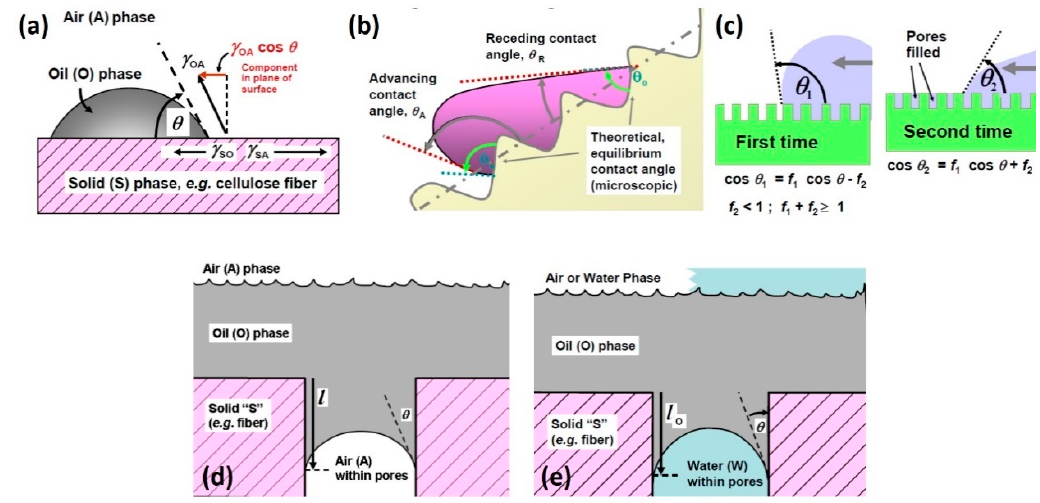
Figure 3. Processes taking place at the liquid–solid interface between oil and sorbent materials. ( a ) Wettability of oil on the surface of a sorbent, ( b ) advancing and receding angles on a rough surface, ( c ) Cassie and Baxter’s theory relative to initial and following wetting of a porous surface, ( d ) penetration of oil into an idealized pore of a dry sorbent, ( e ) penetration of oil into an idealized pore of a water-wet sorbent (adapted and modified from [55]).